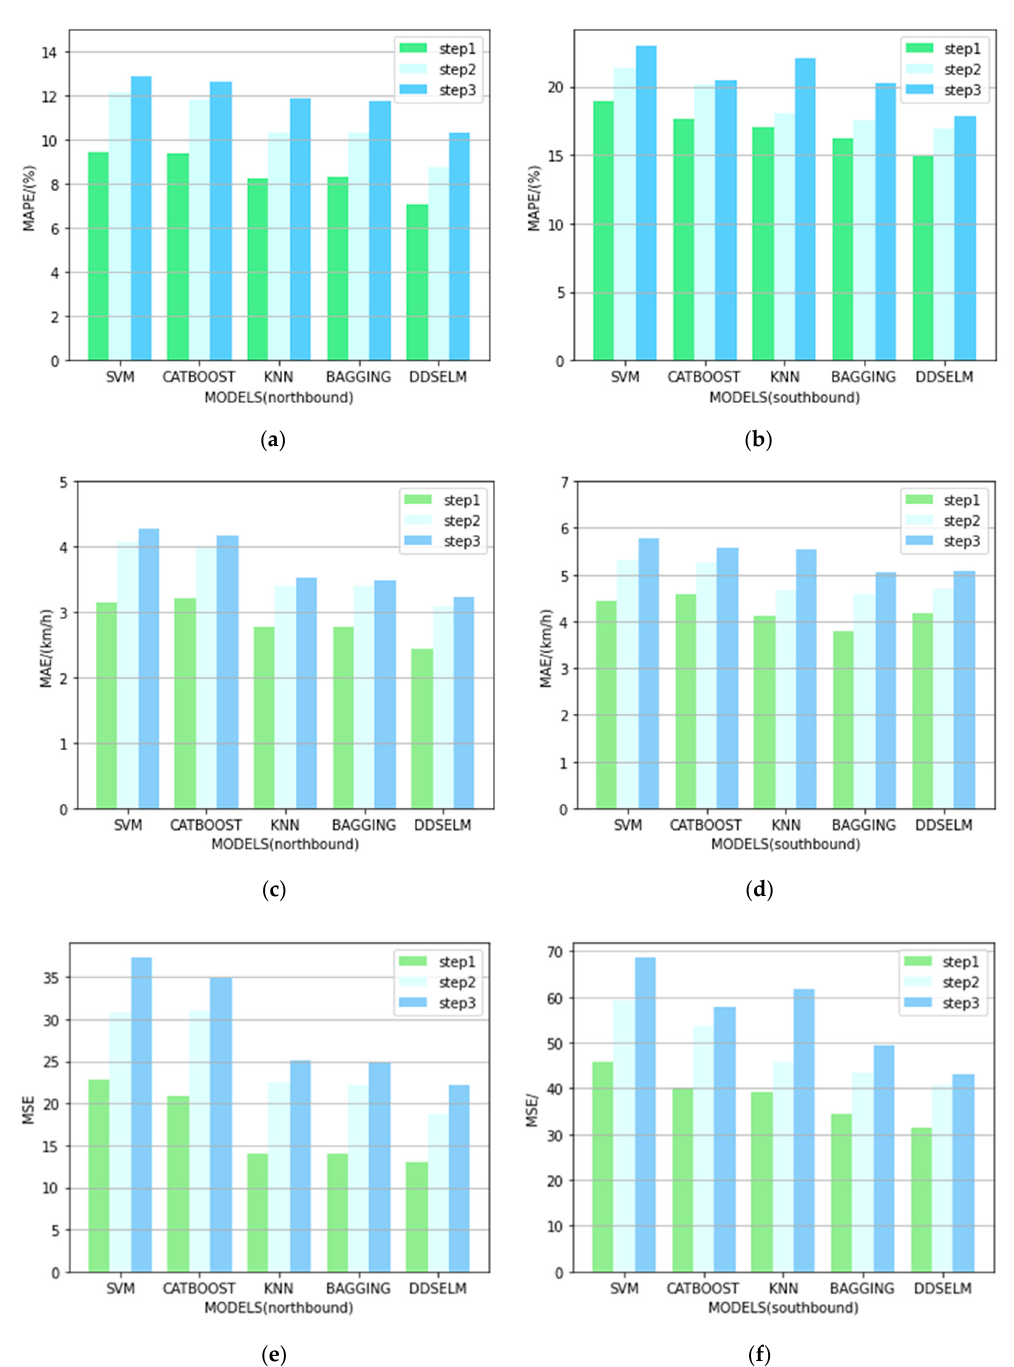
Figure 4. MOEs of five prediction models:( a ) MAPE of five models in northbound; ( b ) MAPE of five models in southbound; ( c ) MAE of five models in northbound; ( d ) MAE of five models in southbound; ( e ) MSE of five models in northbound; ( f ) MSE of five models in southbound.